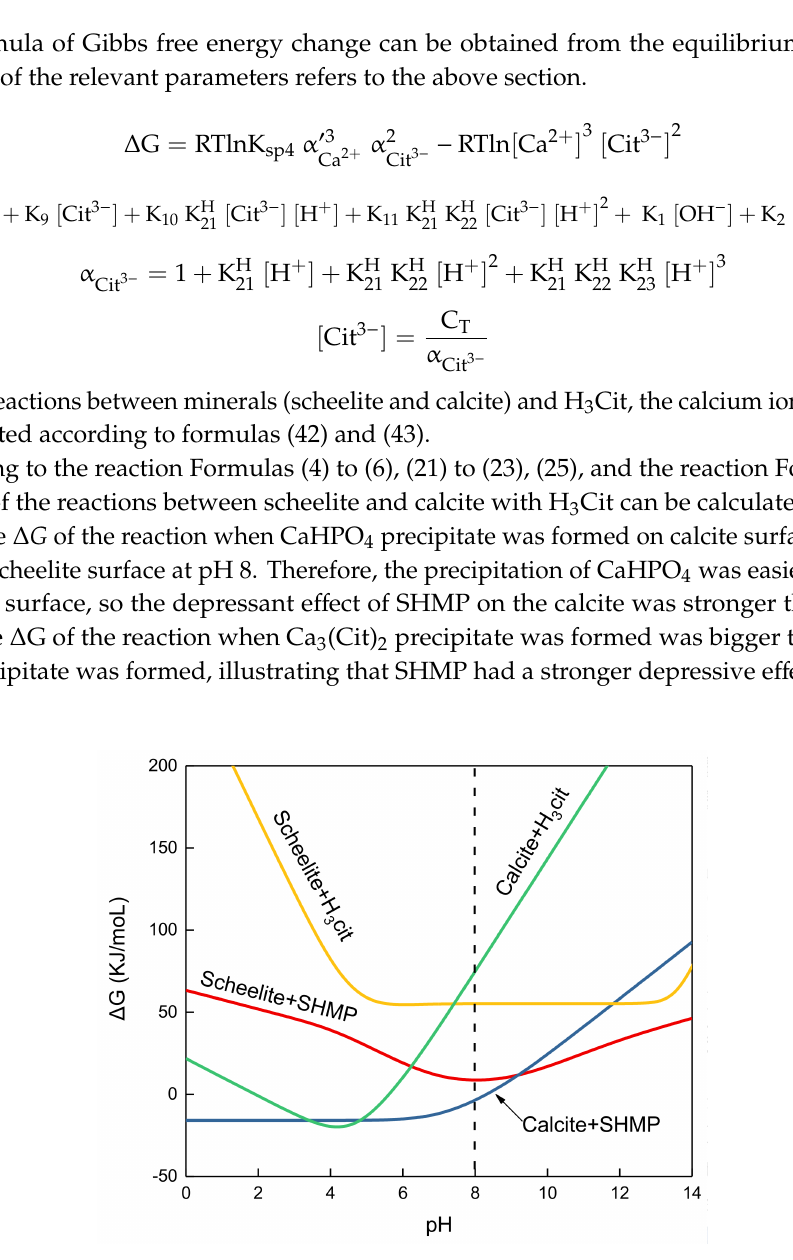
Figure 11. The ∆ G as a function of pH for the reaction of depressants with